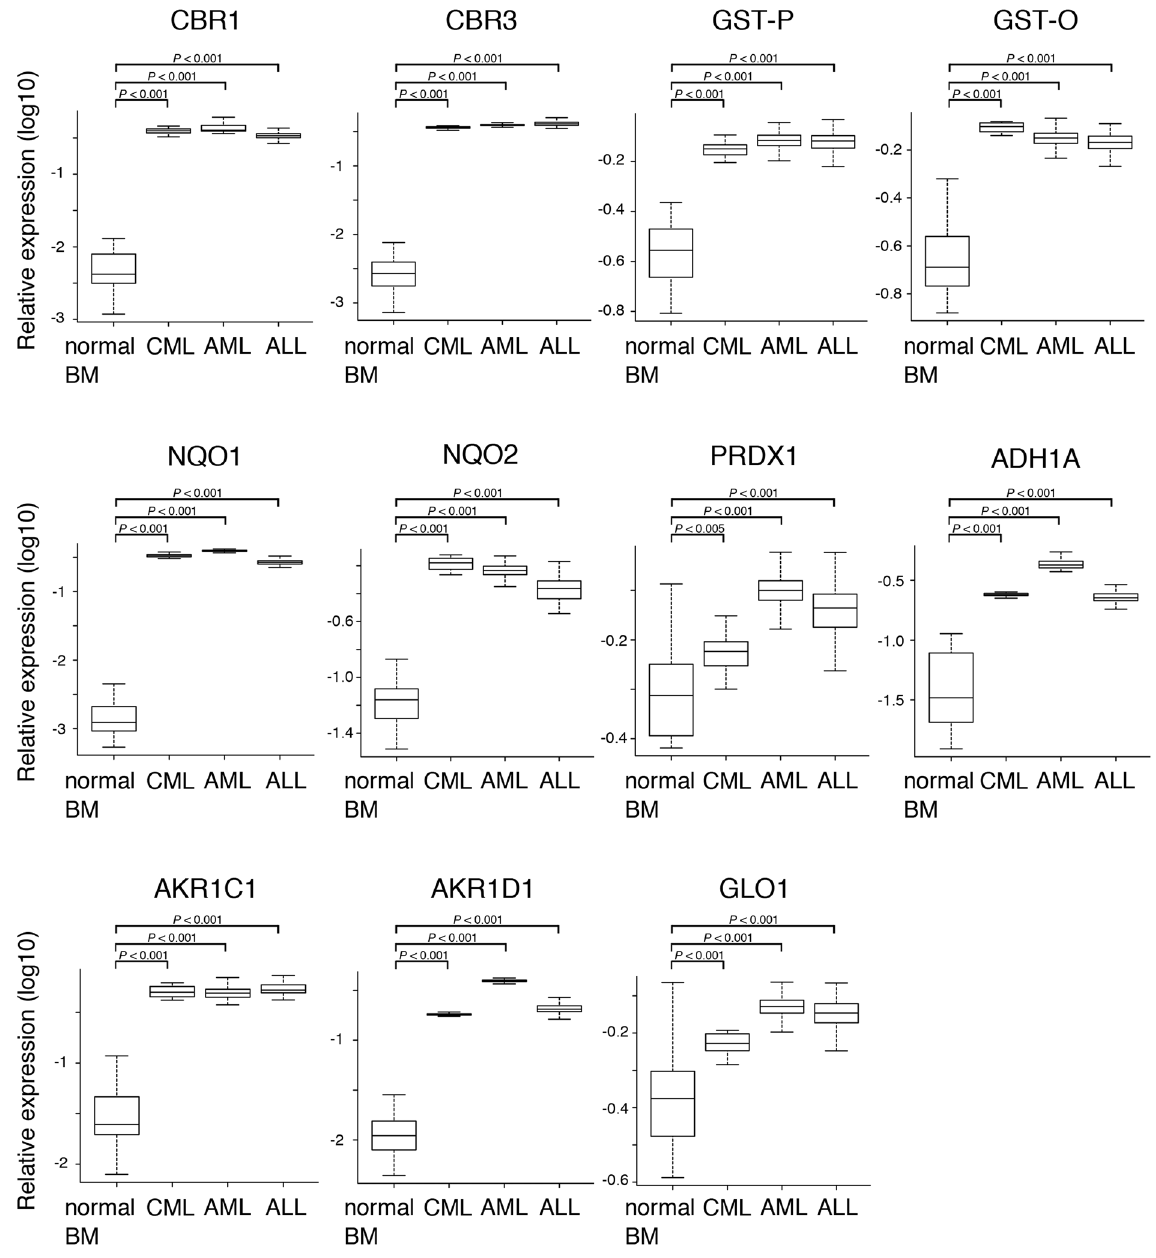
Figure 7. Microarray data analysis of the expression of curcumin interactors in human leukemia. The expression of curcumin interactors (CBR1, CBR3, GST-P, GST-O, NQO1, NQO2, PRDX1, ADH1A, AKR1C1, AKR1D1, and GLO1) in normal bone marrow (n = 22) from healthy donors and CML (n = 18) and AML (n = 461) and T-ALL (n = 100) patients. Gene expression data were obtained from the GEO datasets. Significance was calculated by the Mann-Whitney